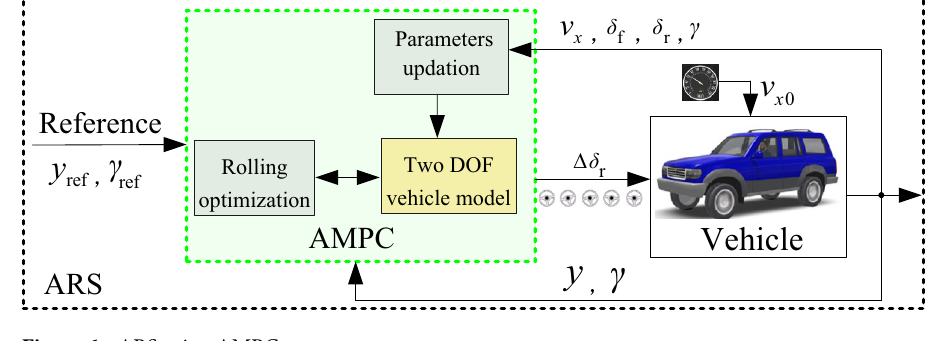
Figure 6. ARS using